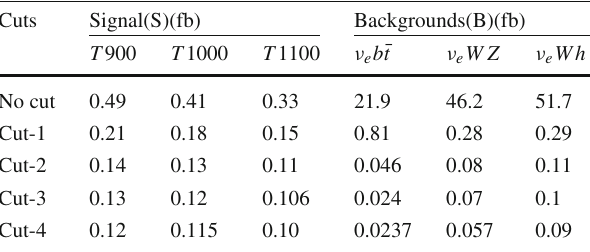
Table1 Cut-flowcross sectionsofthesignalandbackgrounds at 2 . 0 TeV with g ∗ = 0 . 3 Cuts